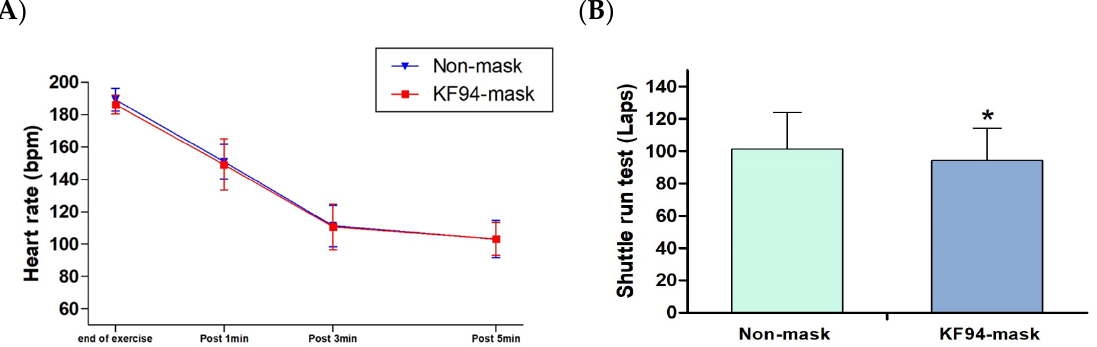
Figure 2. Effects of wearing a KF94-mask compared to no mask on heart rate and shuttle run test. ( A ) Heart rate; ( B ) shuttle run count. * Indicates significant differences ( p < 0.05).